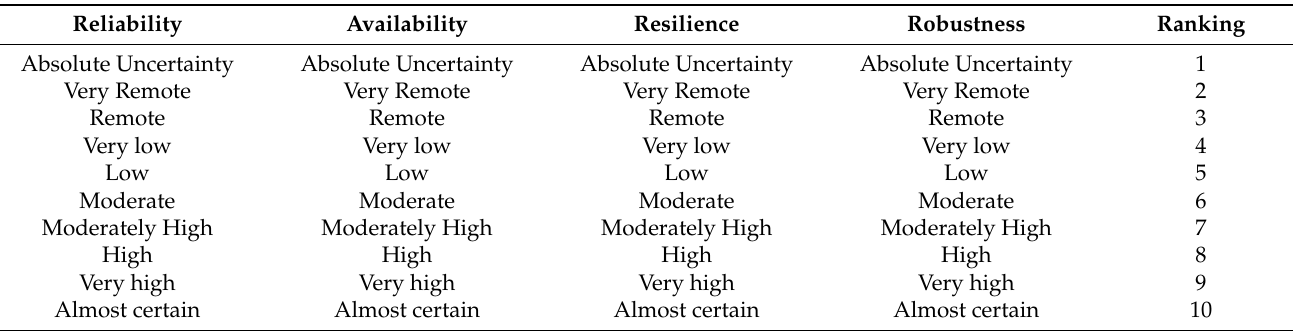
Table 2. Mitigation performance ratings, 10-point rating